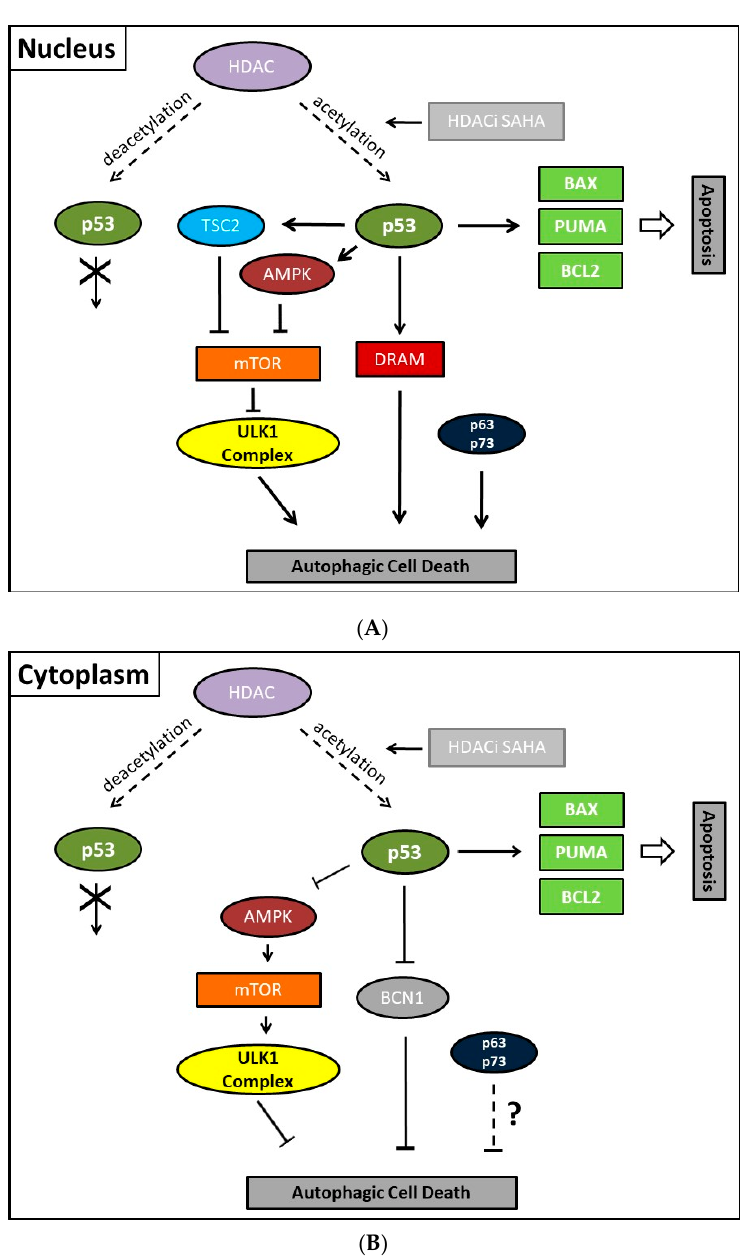
Figure 1. Illustration showing presumed mechanisms mediating SAHA-induced autophagy and its regulation by p53. ( A ) Acetylated p53 primarily induces apoptosis and nuclear p53 is able to induce basic autophagy by transcriptionally upregulating TSC2, AMPK, and DRAM thereby suppressing mTOR and the ULK1 complex further downstream in MES-SA cells. DRAM upregulation or ATG5 upregulation by the p53-family members, p63 and p73 which can compensate for p53 could besides autophagy also mediate apoptosis; ( B ) Concurrently, cytoplasmic p53 protein inhibits autophagic cell death by inducing Beclin-1 degradation and/or inhibiting the AMPK-mTOR-ULK1 signaling pathway. It is unclear whether p63 and/or p73 possibly possess transcription-independent regulating functions for autophagy. Dashed line with arrowhead, deacetylating activity of HDAC; Line with arrowhead (HDACi SAHA), activity of SAHA preventing deacetylation; Fork symbols, transcriptional or enzymatic inhibition by indicated proteins; Arrowlines, transcriptional or enzymatic upregulation or activation by indicated proteins, respectively; Double arrow, major pathway activity.